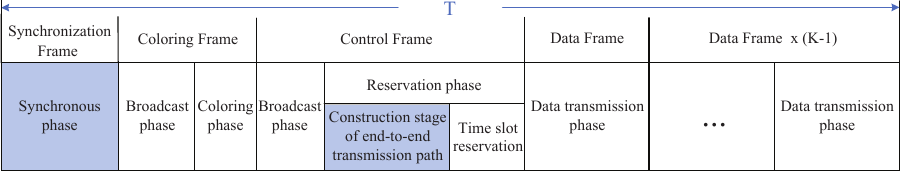
Figure 2. The superframe structure.